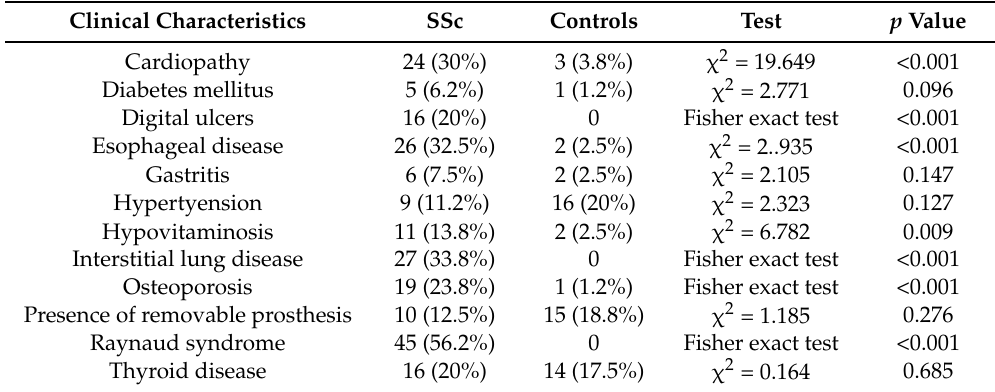
Table 3. Clinical characteristics of SSc patients and controls.